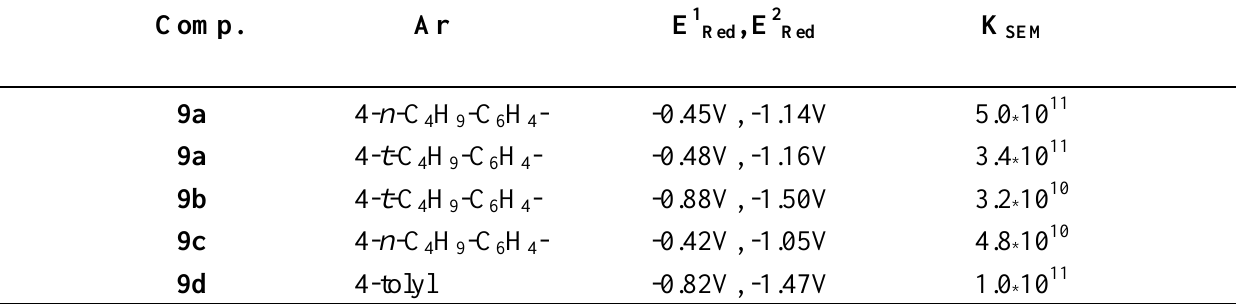
Table 3: Electrochemical properties of the 1,3,2-diazaborolidines 9